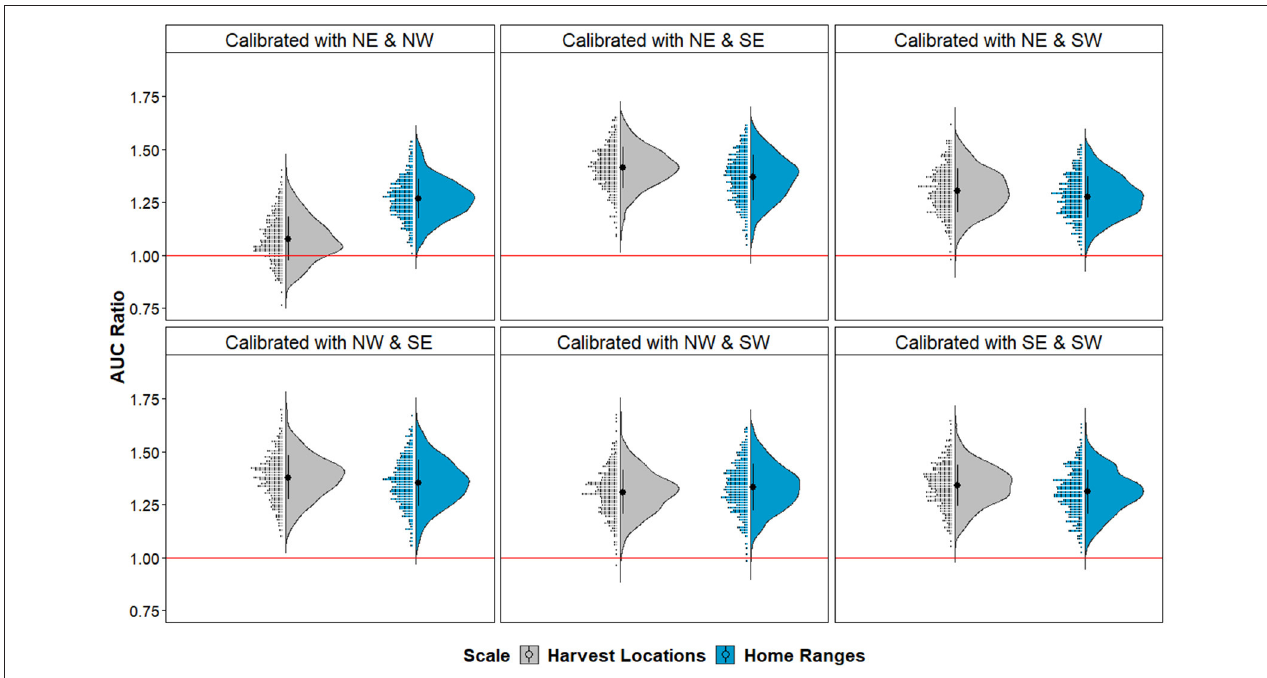
FIGURE 4 | AUC ratio evaluation from partial ROC of continuous suitability maps in each geographic partition. Model evaluation according to different quadrants configuration used for calibration. Half-violin and raw data distribution plots denote bootstrapped AUC ratios obtained from the evaluation quadrants (not used in model calibration) for models based on Harvest Locations (gray) and Home Ranges (blue). Note that most configurations have AUC ratios > 1, which is above the threshold for random expectation (red line; p < 0.001), except for one Harvest Location model calibrated with the northeast and northwest quadrants with non-significant predictions ( p > 0.05). Ribbon abbreviations follow cardinal directions (i.e., NE, northeast; NW, northwest; SE, southeast; SW,